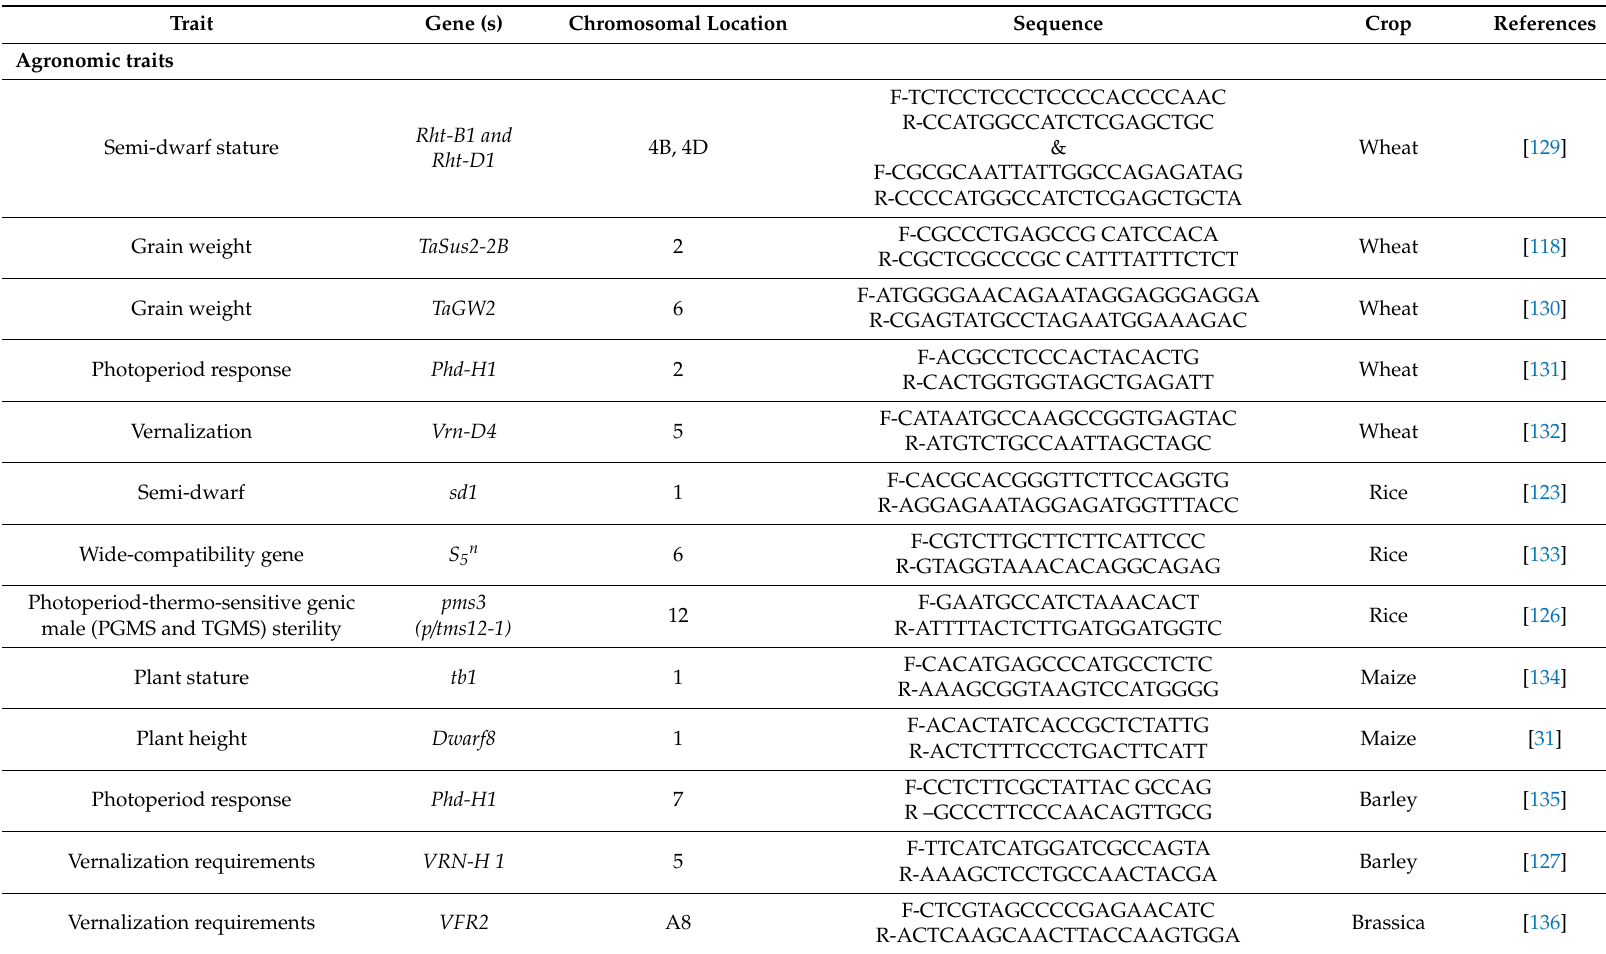
Table 1. Candidate genes for functional markers (FMs) development for di ff erent